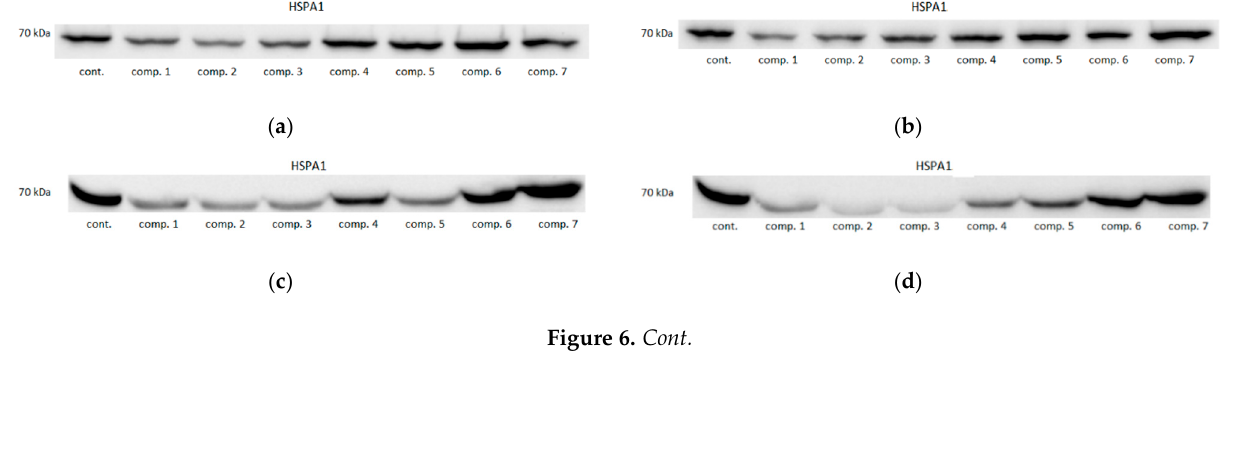
Figure 5. Effect of oxicams on HSPA1 protein expression in colorectal adenocarcinoma cell lines: ( a ) Caco-2; ( b ) HCT 116; ( c ) HT-29. Data presented as means ± SEM ( n = 3) of normalized expression in treated against untreated cells [T/U] and analyzed using t -test for one mean. Statistical significance ( p < 0.05) is indicated by asterisks (*) and protein expression in control (untreated) cells is indicated by horizontal red solid line. Cells were treated with 50 µM or 200 µM oxicams for 48 h. Compound #6 denotes piroxicam and